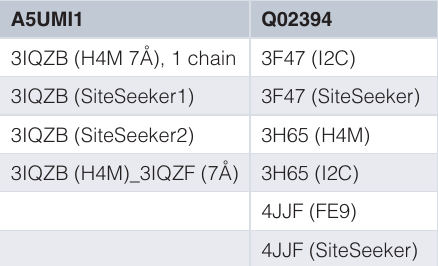
Table 1. Ligand binding sites identified and inferred from models. Four sites from the A5UMI1 modeling and six sites from Q02394 modeling were used in the docking